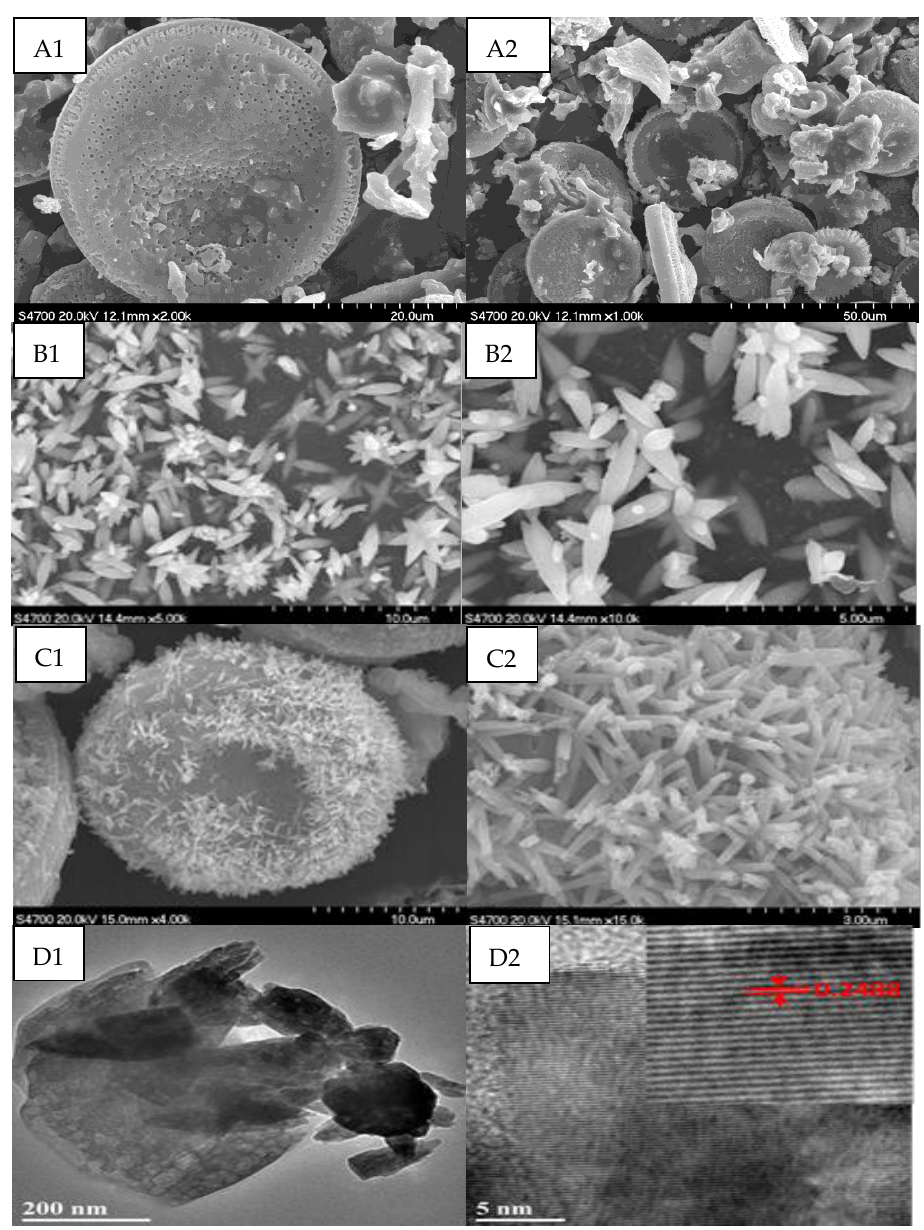
Figure 2. SEM images with different magnifications of (A1, A2) diatomite, (B1, B2) ZnO, and (C1, C2) 10% ZnO@diatomite; (D1, D2) HRTEM images of 10% ZnO@diatomite.